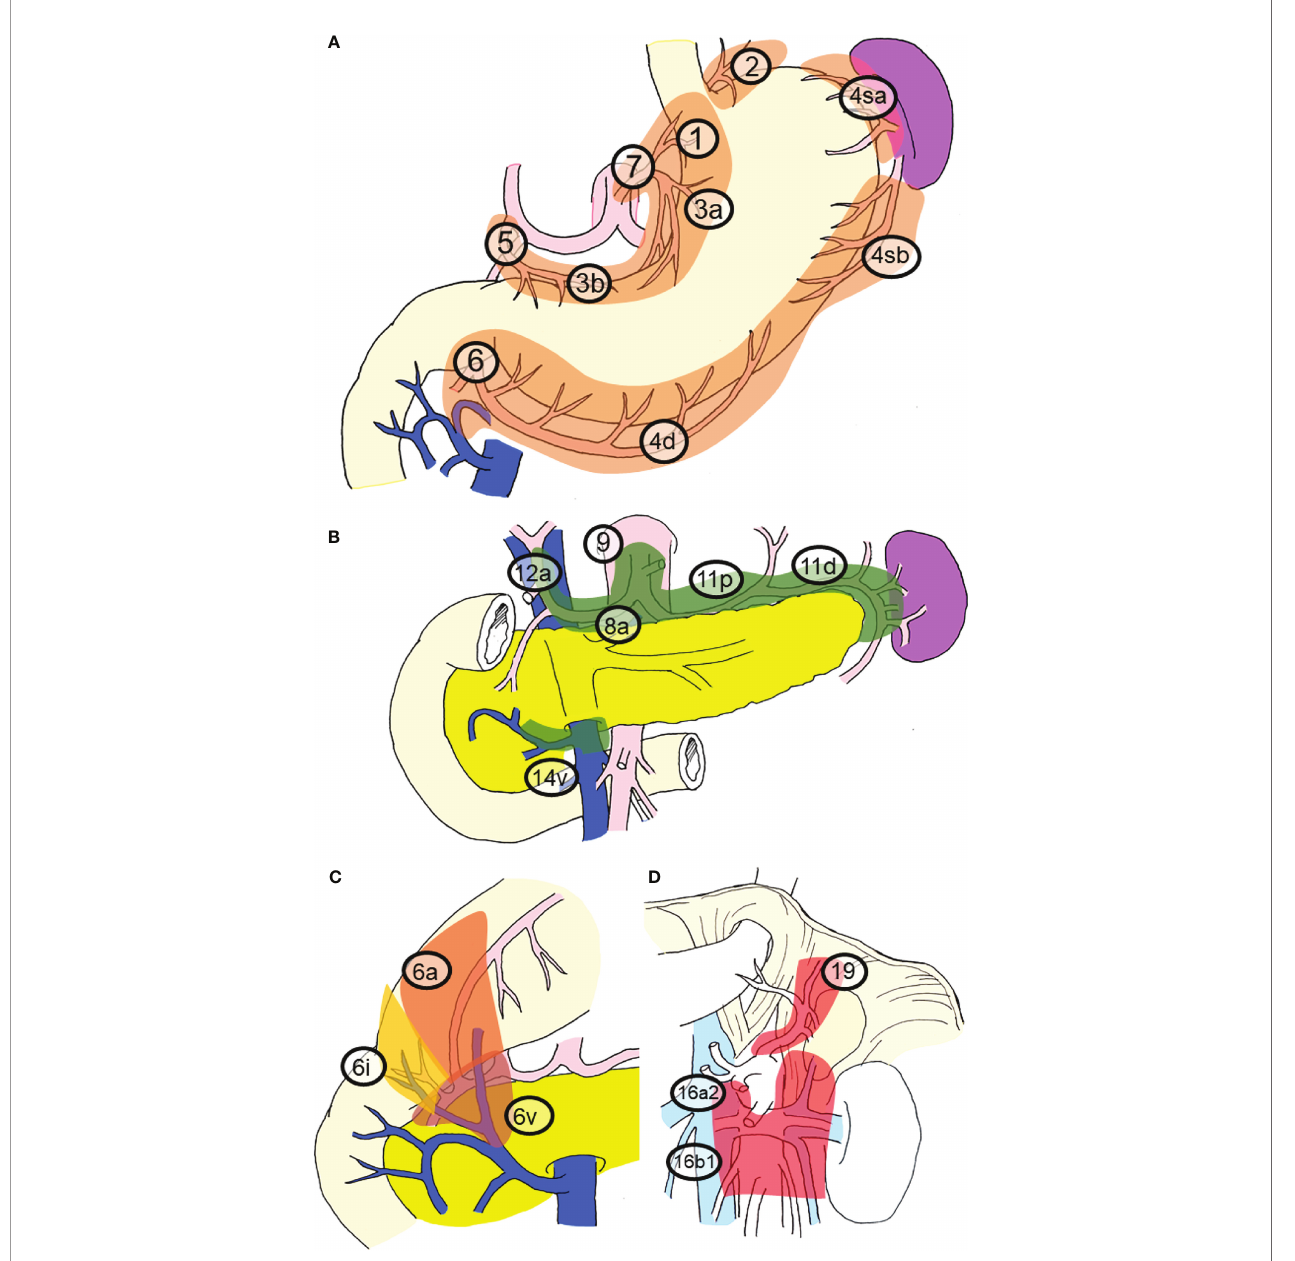
FIGURE 1 | Regional lymph nodes and station numbers in gastric cancer. This classi fi cation and the station numbers are based on the Japanese Classi fi cation of Gastric Carcinoma. The details of the nodal station numbers have been described in Table 2 . (A) Perigastric nodes and nodes along the left gastric artery. These nodes nearly correspond to group 1 nodes. (B) Nodes around the celiac artery, along the proper hepatic artery and suprapancreatic nodes. These nodes nearly correspond to the group 2 nodes. (C) The subcategory of No. 6 nodes. (D) Nodes in deeper layers. Para-aortic lymph nodes and No. 19 nodes. These nodes nearly correspond to group 3